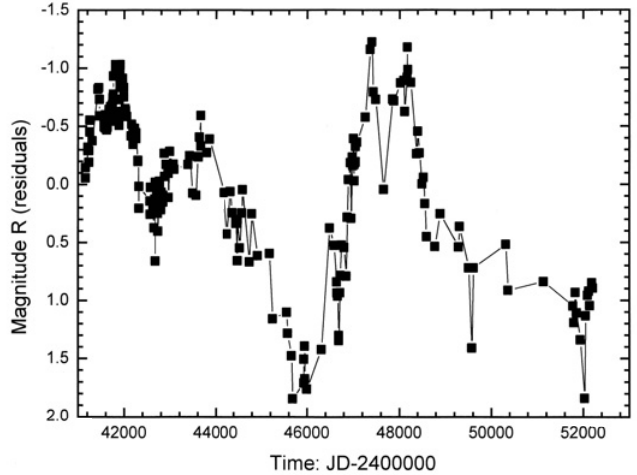
Fig. 6. Pre-whitened light curve of V1568